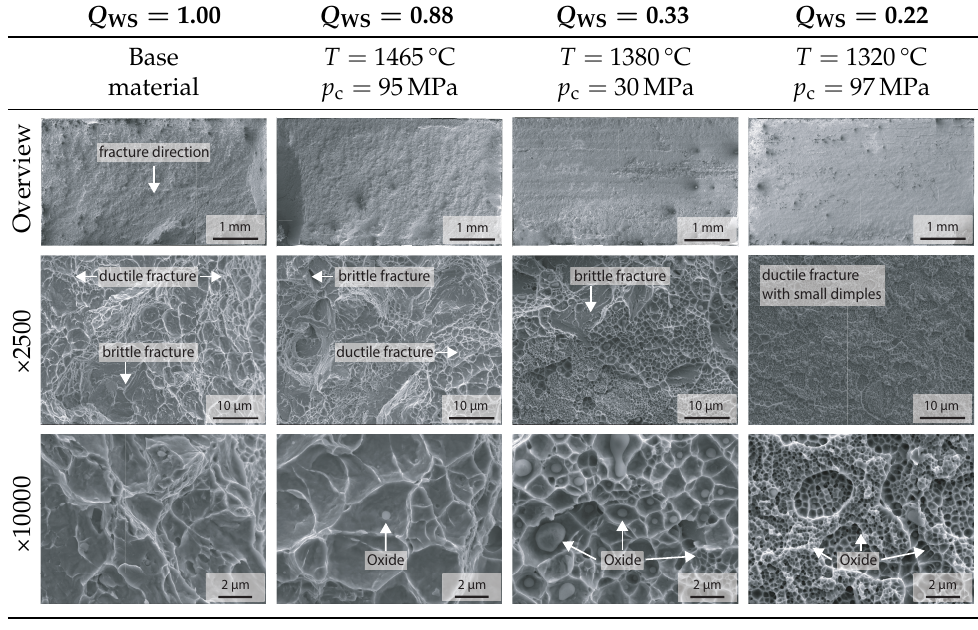
Table 8. Comparison of the fracture surfaces of the hardened bending specimens of 34MnB5 steel sheets welded with different welding parameters ( T , p c ) and different weld seam strength ratios Q WS . Q WS =